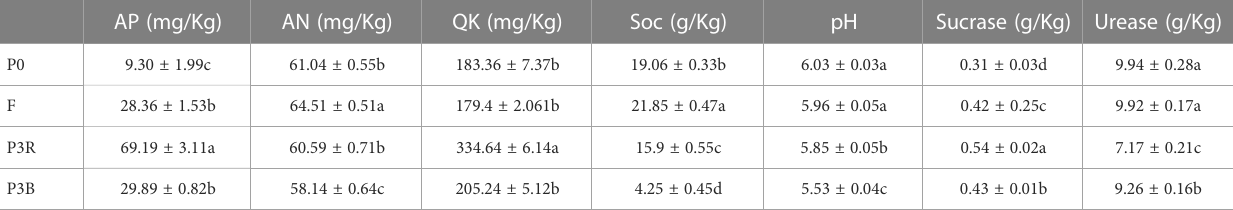
TABLE 1 Contents of AN, AP, QK, SOC, and pH value, sucrase activity, and urease activity.